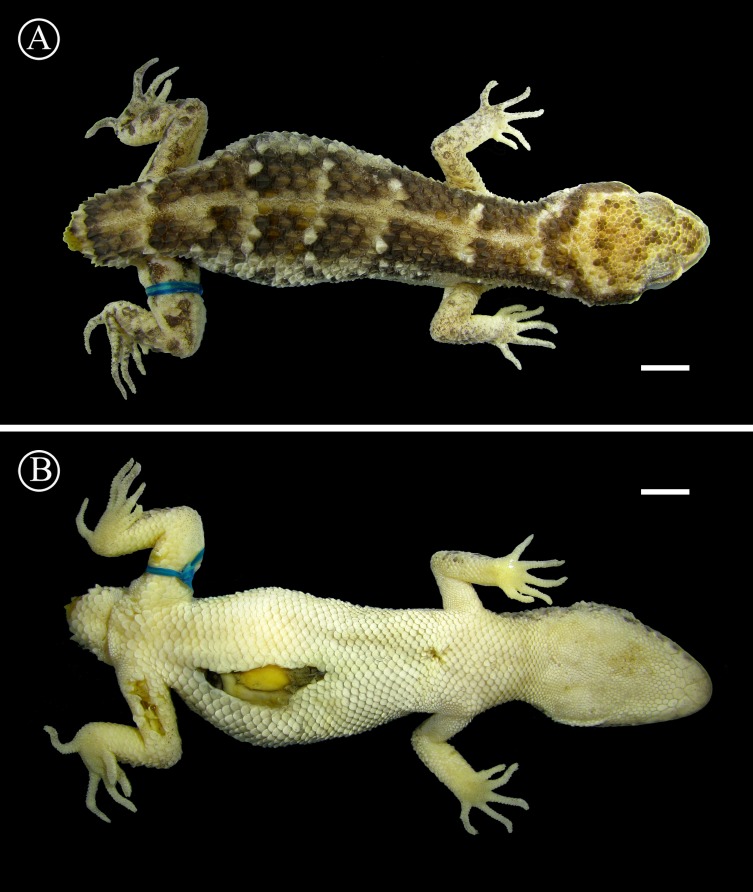
Holotype of Homonota septentrionalisDorsal (A) and ventral (B) views of the holotype of Homonota septentrionalis (MNHNP 12238). Scale bar = 5 mm.